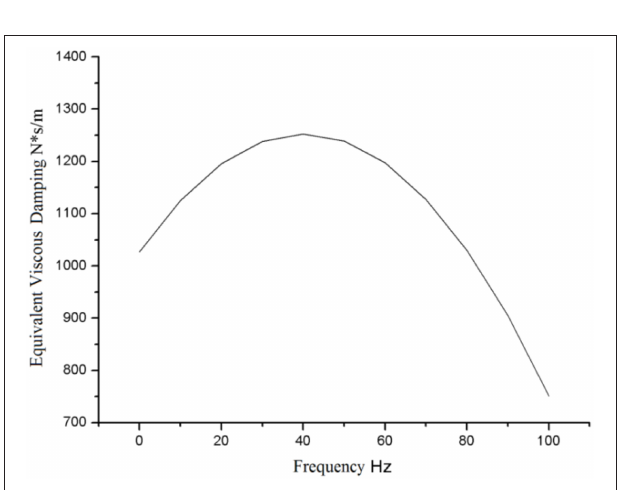
FIGURE 11 | Fitting results of equivalent viscous damping of MR